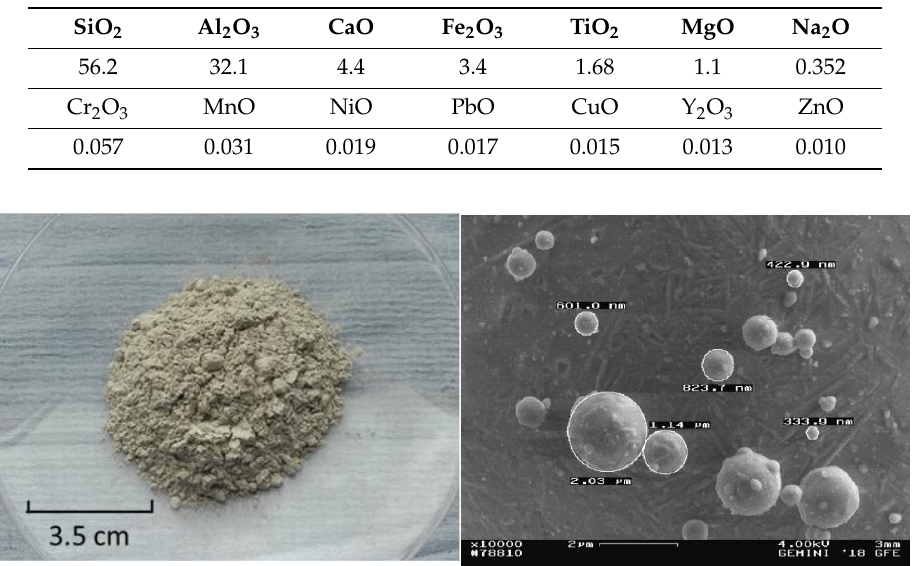
Table 6. Design of the experiment.